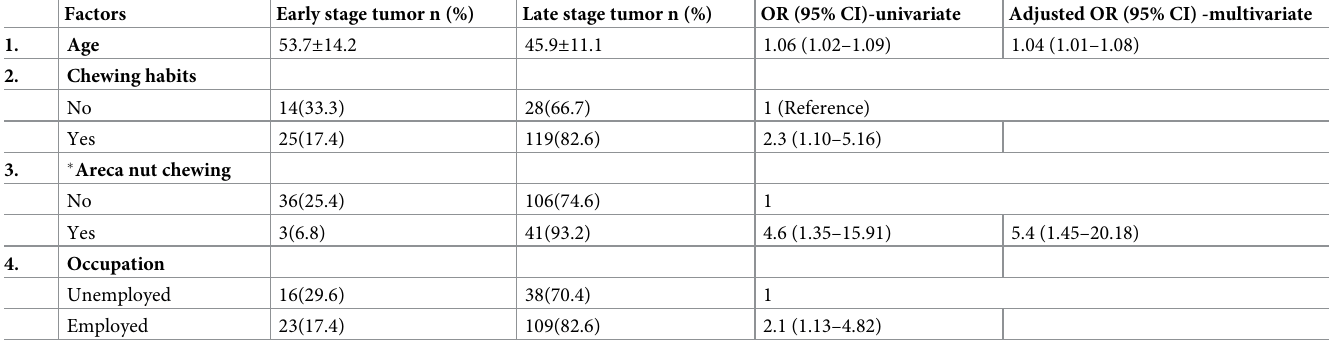
Table 4. Model 3, univariate and multivariate regression analysis for significant association of tumor stage of OSCC patients with